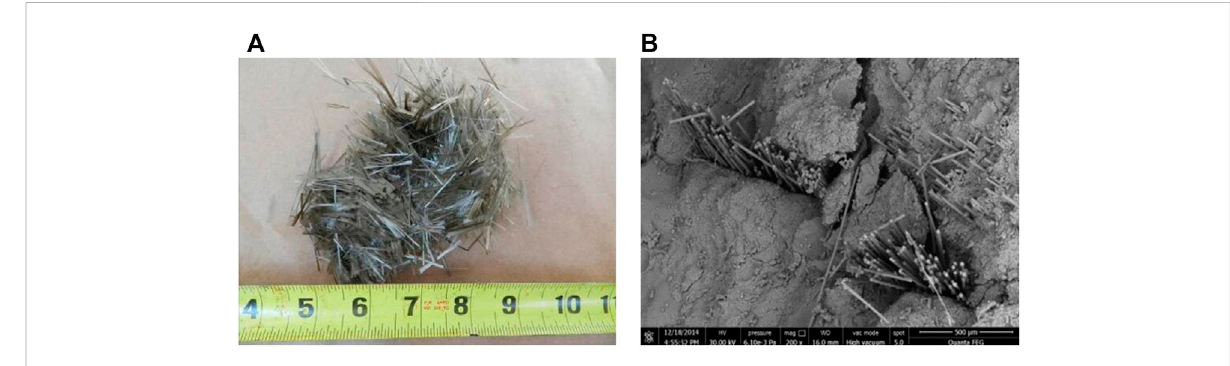
FIGURE 1 Morphology of basalt fi ber and SEM (High et al., 2015; Girgin and Yildirim, 2016) (A) Macroscopic morphology (B) SEM